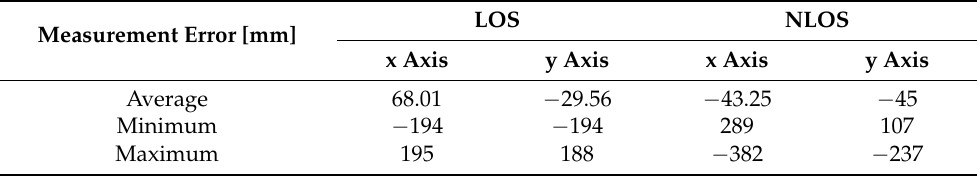
Table 1. Indoor LOS and NLOS measurement